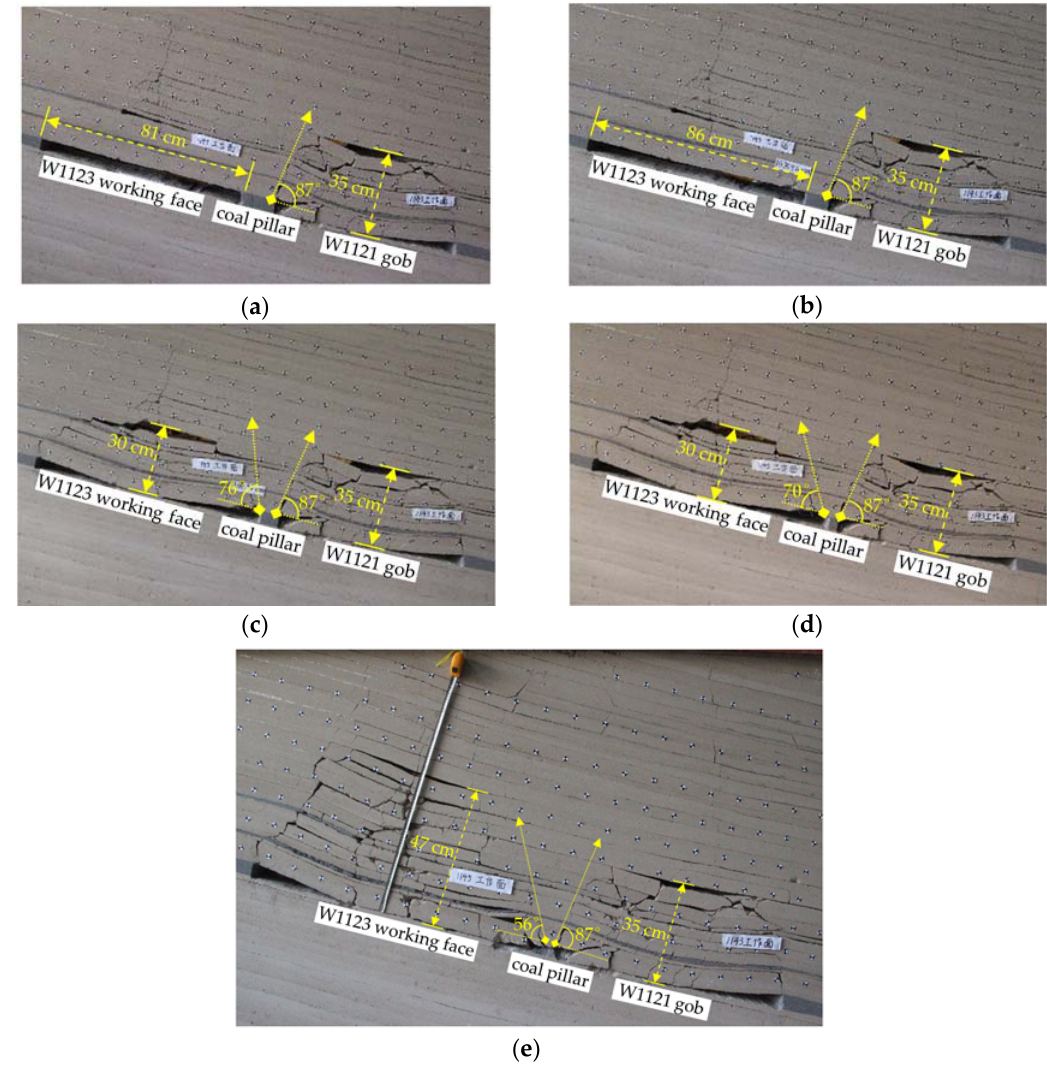
Figure 10. Roof inclined fracture structure of working face with different width. ( a ) Mining 162 m; ( b ) mining 172 m; ( c ) mining 177 m; ( d ) mining 182 m; ( e ) mining 184 m.